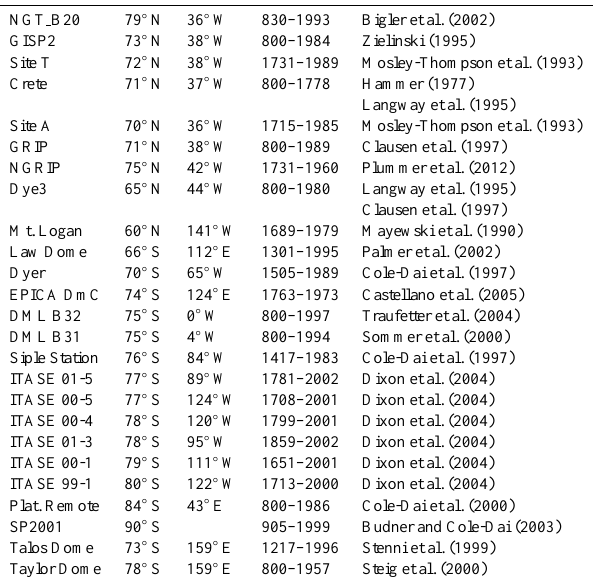
Table 1. Location and duration in years AD of sites used in this